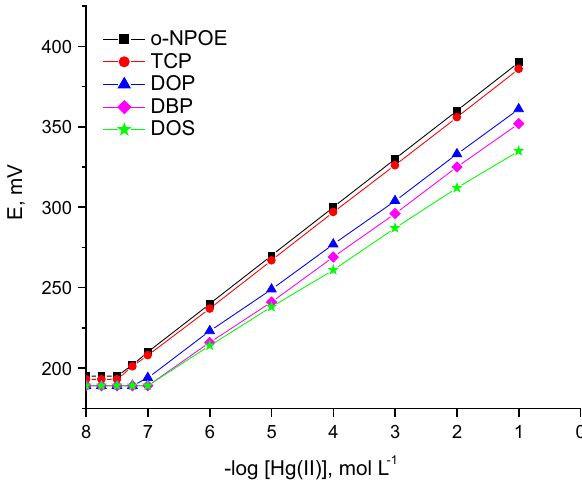
Fig. 4 Dynamic response time of Hg(II) modified SPE sensor